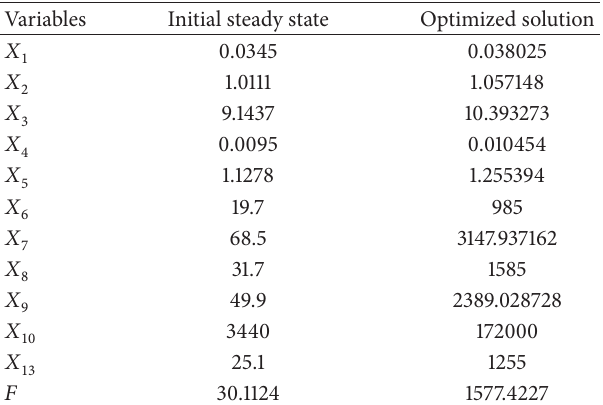
Table 3: Optimal solution of Case study 2 obtained by using the proposed